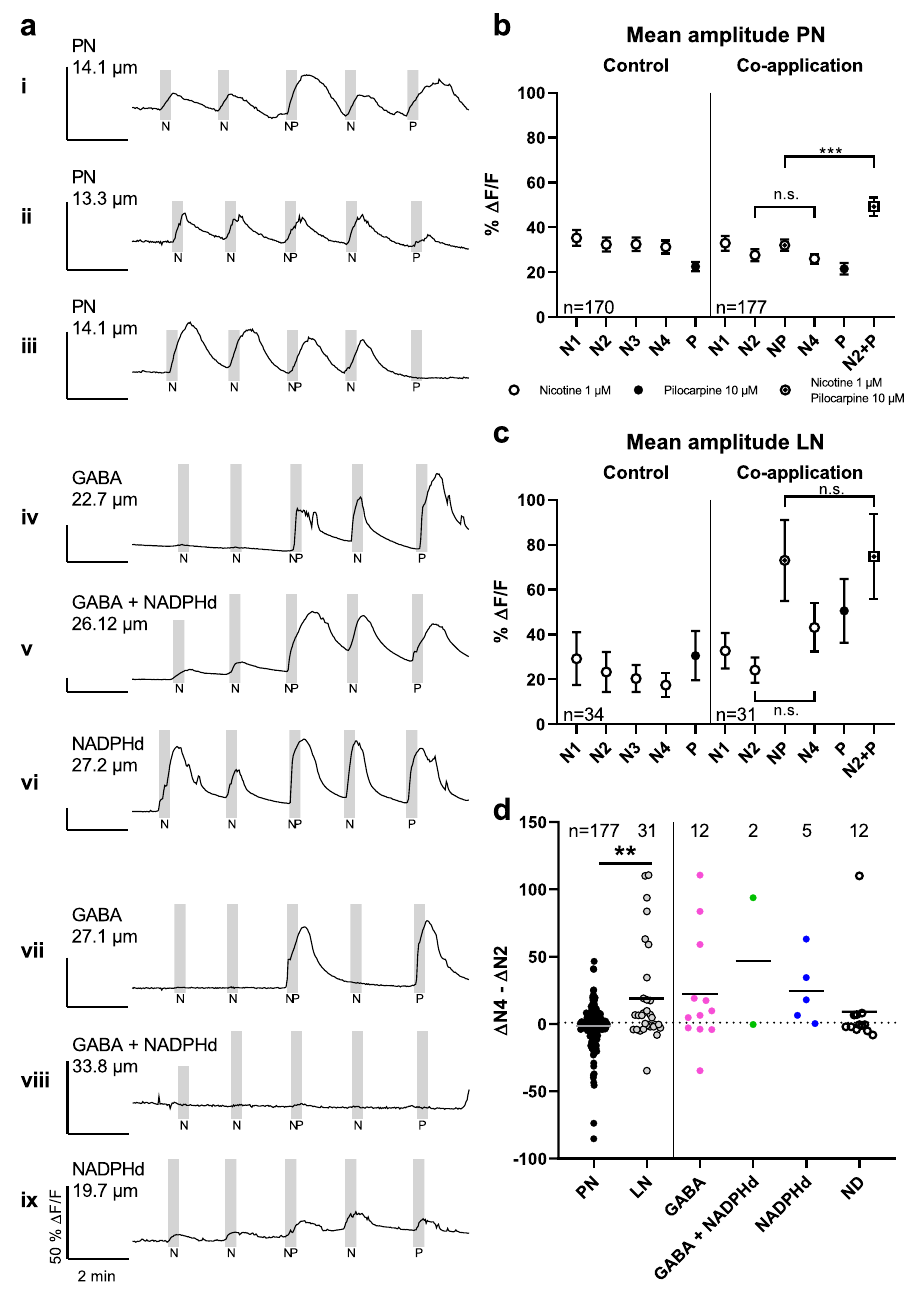
Figure 6. Ca 2+ response alterations by interaction of muscarinic and nicotinic stimulation. To test for lasting response alterations, a series of two 15 s pulses of 1 µM nicotine (N1 & N2), one pulse of a 1 µM nicotine and 10 µM pilocarpine mix (NP; no pilocarpine in controls N3), one nicotine test pulse (N4) and one pilocarpine pulse (P) were given in consecutive order. Stimulations are shown as vertical gray band. a shows examples of Ca 2+ signals in the co-application protocol. Note that scale varies for better visibility, but all represent 50 %ΔF/F. a shows various traces of PN ( i — iii ) and different LN types ( iv - ix ). Nicotinic responses were enhanced after co-application in several LN of all types ( a iv — vi ), but not in PN. This response enhancement was not found in all of the sampled LN ( a vii — ix ). b and c depict mean Ca 2+ responses (± s.e.m.) of PN and LN normalized to calcimycin response. Responses to nicotine (empty circle), pilocarpine (filled circle), or nicotine/ pilocarpine mix (circled dot) are shown in order of application. The predicted N2 + P value (squared dot) was calculated as the sum of individual nicotine and pilocarpine responses during co-application. These predicted responses were significantly different to the respective co-application response in PNs ( p < 0.0001, Friedman test), but not in LN ( p = 0.1802, Friedman test). In PNs as well as LN ( b & c ), nicotinic amplitudes before and after co-application were not significantly different to each other ( p > 0.9999 respectively, Friedman test). To account for variability in baseline responsiveness, amplitude differences of nicotinic stimulations after (N4) and prior to co-application (N2) of individual PN (black), LN (gray) and their respective subtypes were calculated ( d line represents mean). Amplitude differences of LN were significantly different to those of PNs ( p = 0.0073, Mann–Whitney test), demonstrating an enhancement of nicotinic responses after co-application of the muscarinic and nicotinic